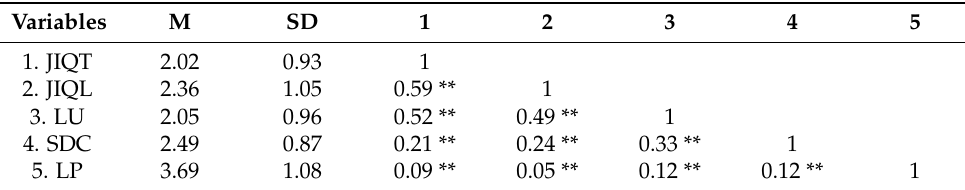
Table 3. Means (M), Standard Deviation (SD), and correlations of study variables. Variables